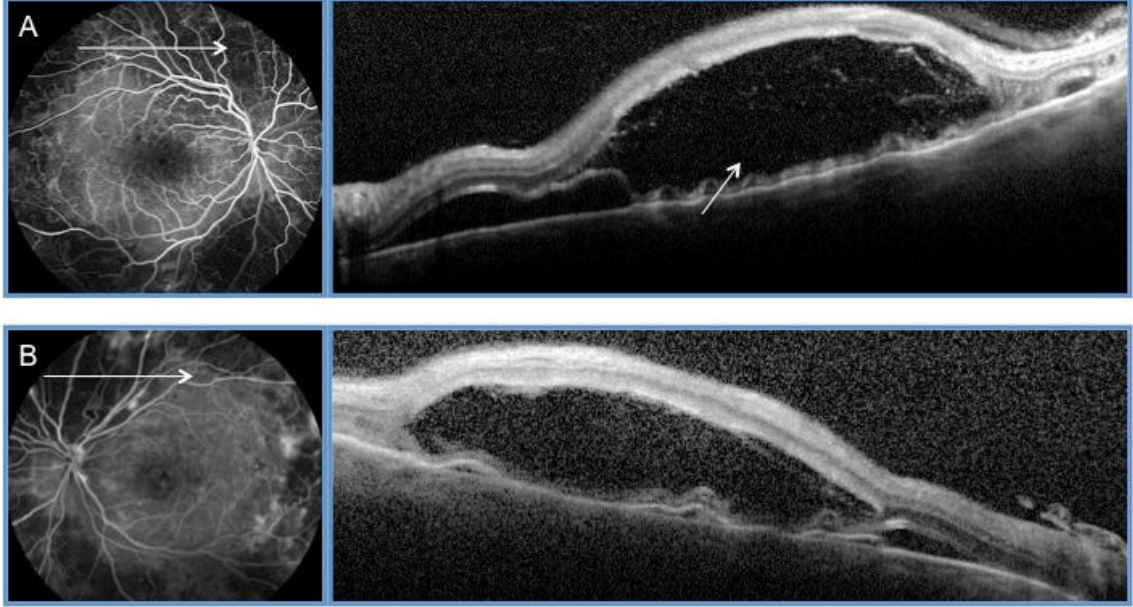
Figure 2: SD-OCT showing a large serous retinal detachment (SRD) at the level of the temporal superior arcade (arrow) OD 2 days following PRP with the PASCAL photocoagulator (A). A similar image was seen in the fellow eye